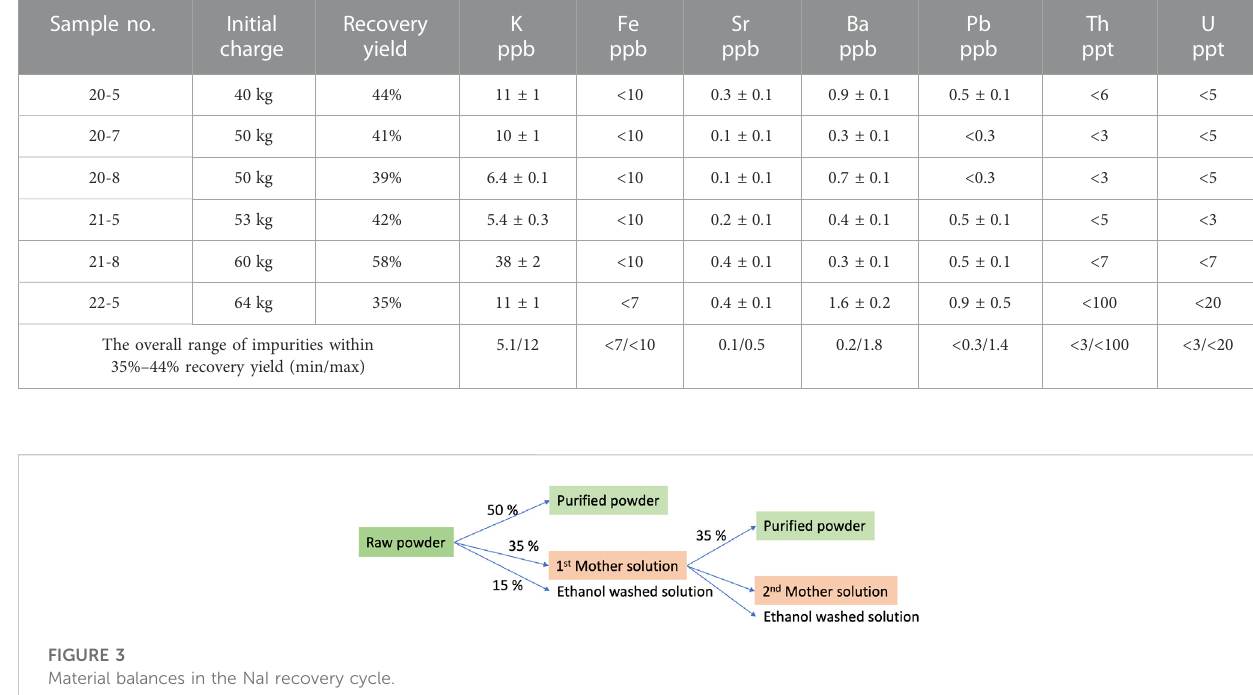
TABLE 3 The ICP-MS results of puri fi ed powders in different batches of raw powder puri fi cation. Uncertainties are given at 90% C.L, and upper limits are given at 95% C.L. Sample no.